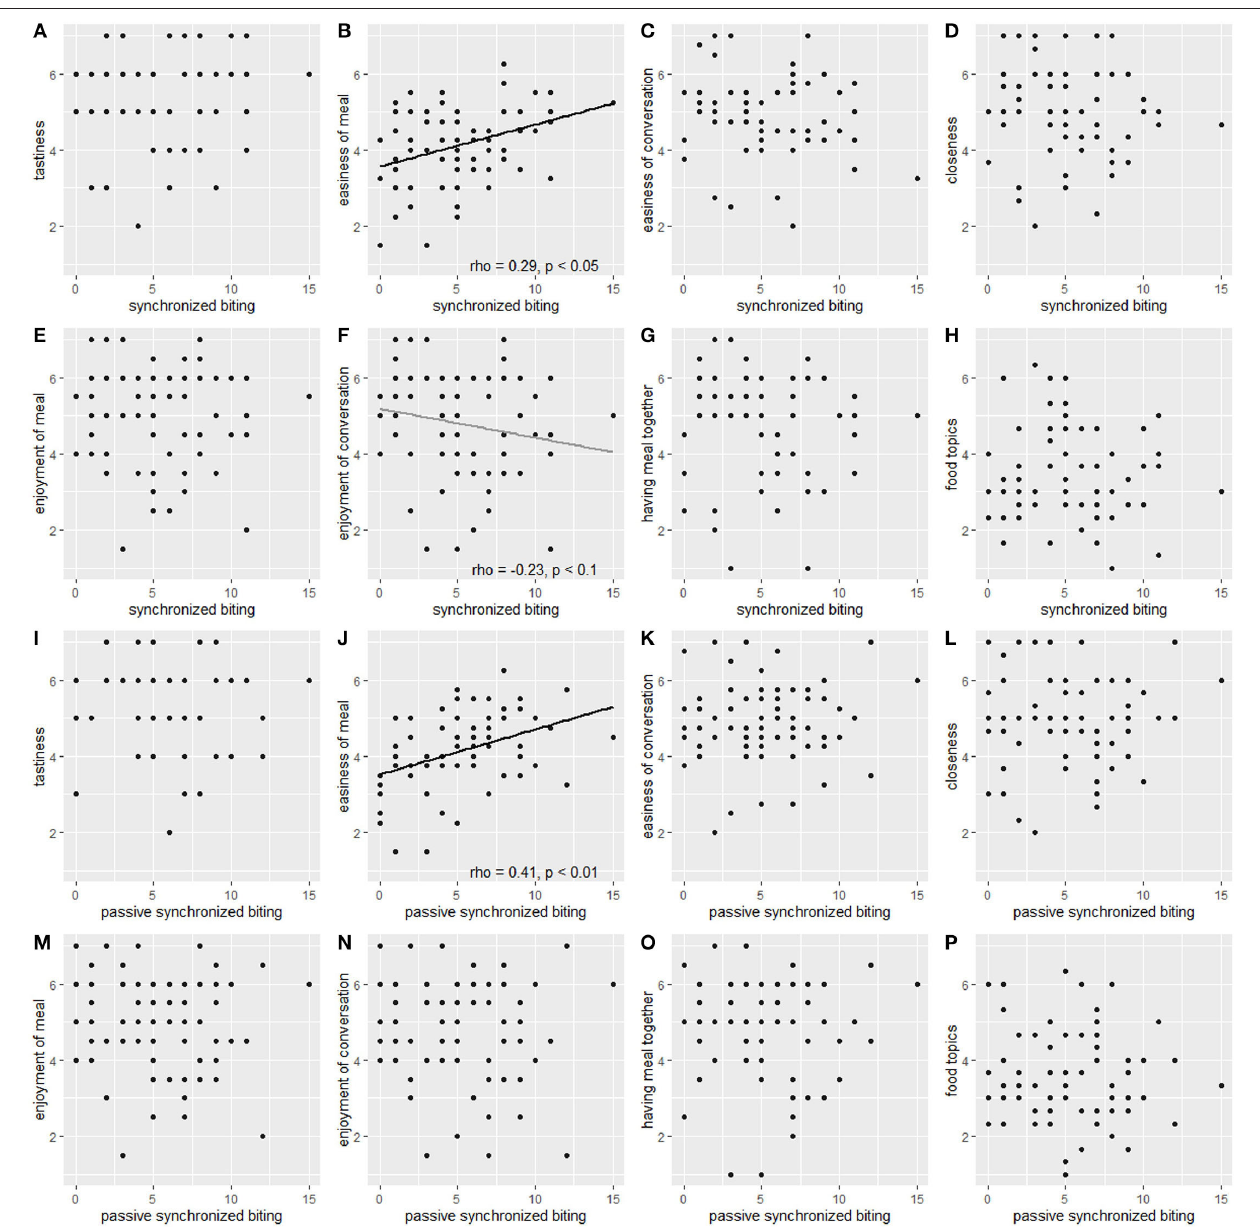
FIGURE 10 | Relationships between (A–H) the amount of either-two-synchronized biting and subjective feelings and (I–P) the amount of either-two-passive synchronized biting and subjective feelings ( N =